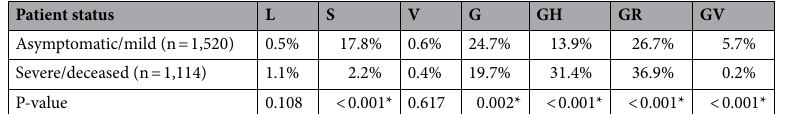
Table 2. Distribution of SARS-CoV-2 clades with respect to patient’s clinical status. P-values were calculated using Chi-square test. *P-values < 0.05 are statistically significant.